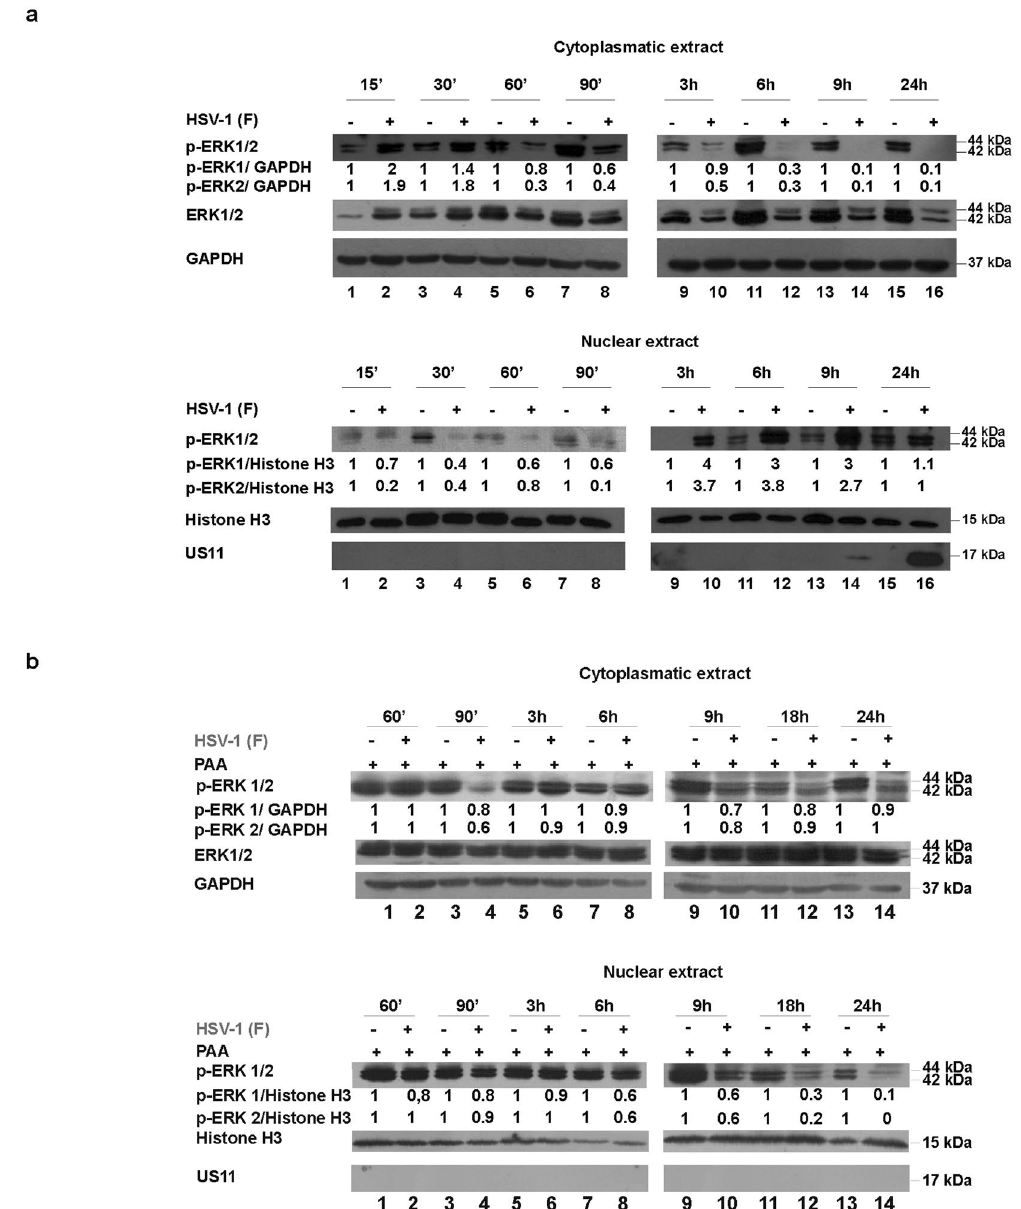
Figure 2. Expression of phospho-ERK1/2 proteins in HEp-2 cells infected with HSV-1 and PAA treated. ( a ) HEp-2 cells were infected or mock infected with HSV-1 at MOI 10 and collected at different times p.i. (15 ′ , 30 ′ , 60 ′ , 90 ′ , 3, 6, 9 and 24 hrs). Equal amount of cytoplasmic and nuclear proteins were separated by polyacrylamide gel electrophoresis and probed with phospho-ERK1/2 (p42/44), ERK1/2 and US11 antibody. GAPDH and Histone 3 proteins were used as housekeeping for the cytoplasmic and nuclear fraction, respectively. ( b ) Cells were infected or mock infected and treated with 300 µ g/ml phosphonoacetic acid (PAA) and collected at 60 ′ , 90 ′ , 3, 6, 9 18 and 24 hrs. PAA was added at the time of adsorption and maintained throughout the course of infection and processed as described in panel b. Band density was determined with the T.I.N.A. program, and was expressed as fold change over the appropriate housekeeping